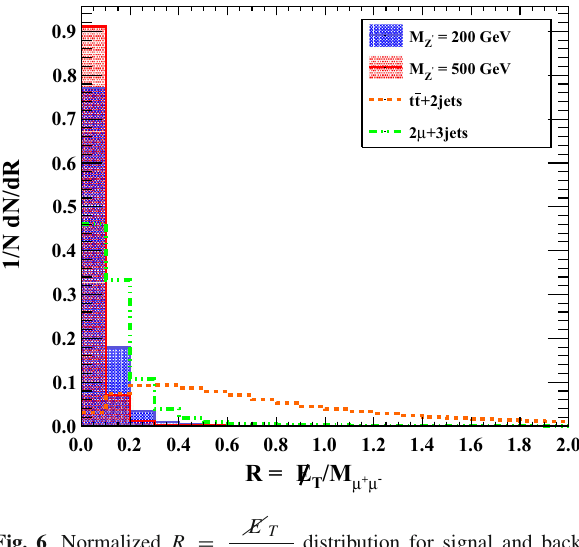
(cid:3) E T Fig. 6 Normalized R = distribution for signal and back- M μ + μ − grounds bution of R . For this reason, for the signal, R peaks at a